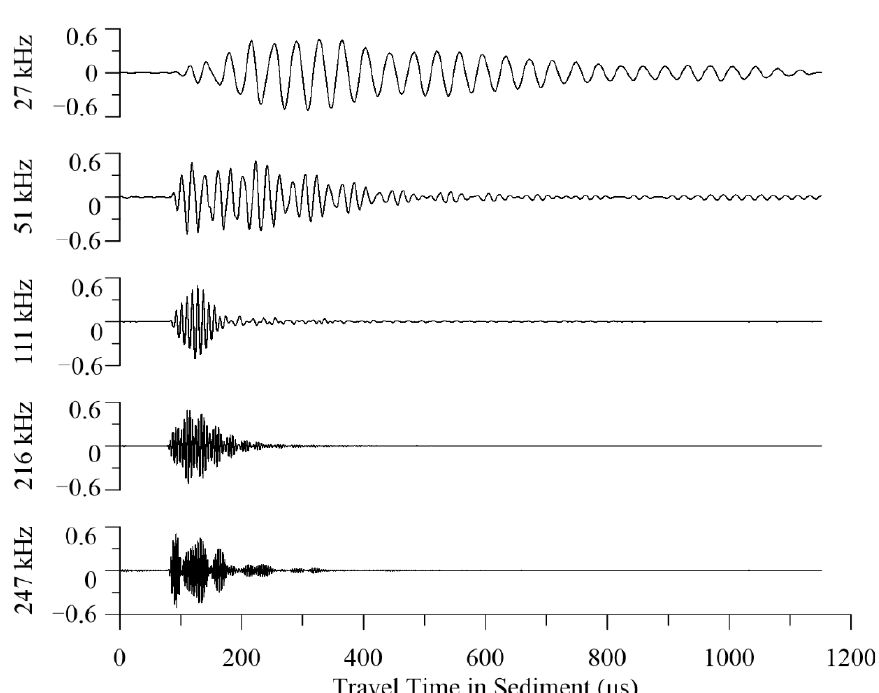
Figure 2. The waveforms of sound signals at different frequencies recorded by the acoustic